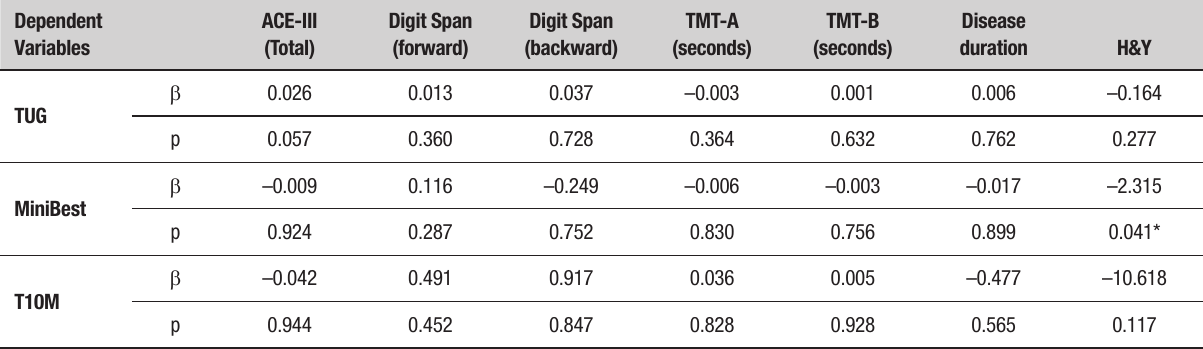
Table 3. Multiple linear regression